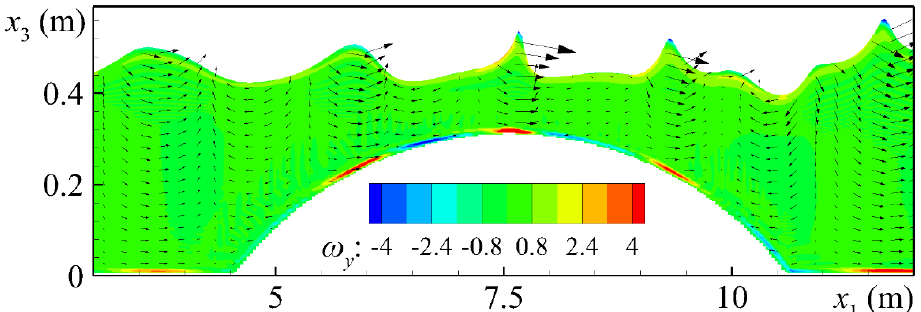
Figure 4. Instantaneous flow field, at the cross section of the domain centerline, for case C2: velocity (vectors) and spanwise vorticity, ω y , (contours). The ratio of the horizontal axis scale to the vertical one is 0.2.